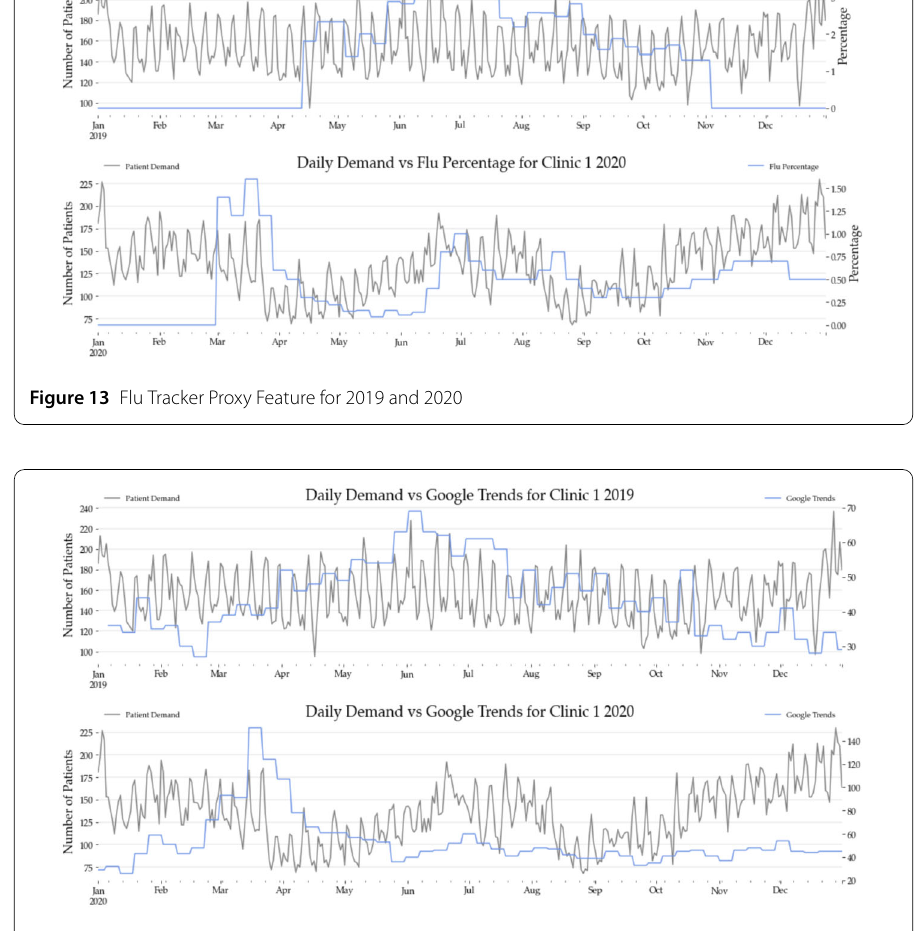
Figure 14 Google Trends Proxy Feature for 2019 and